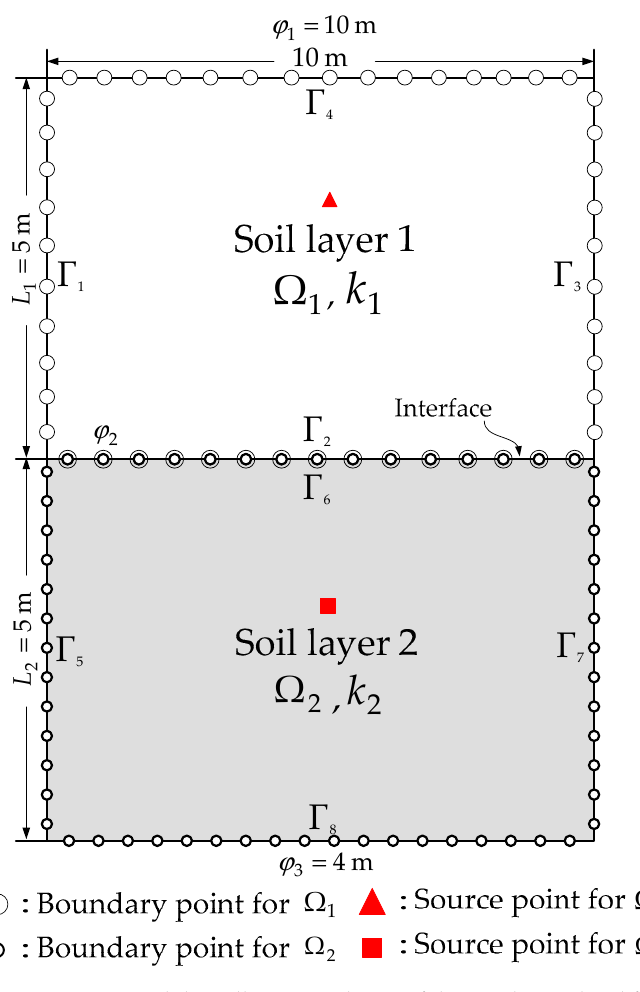
Figure 3. The cross section and the collocation scheme of the two layered soil for the analysis.